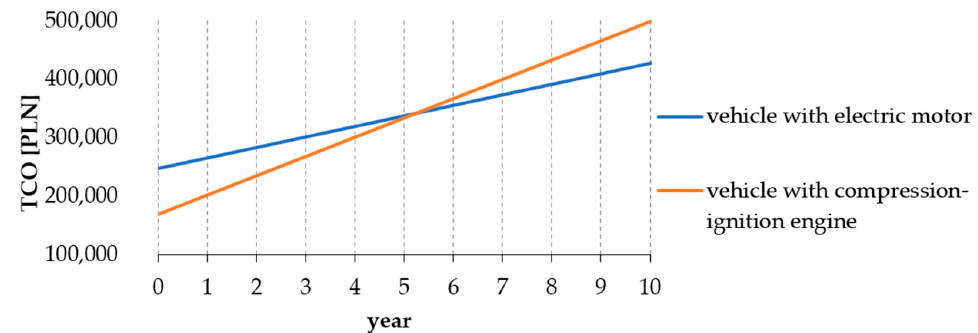
Figure 22. Total cost of ownership of vehicle during the whole operating period—electric vehicle is recharged only at public AC charging stations (the lowest price for 1 kWh was included in the calculations—Scenario B2).